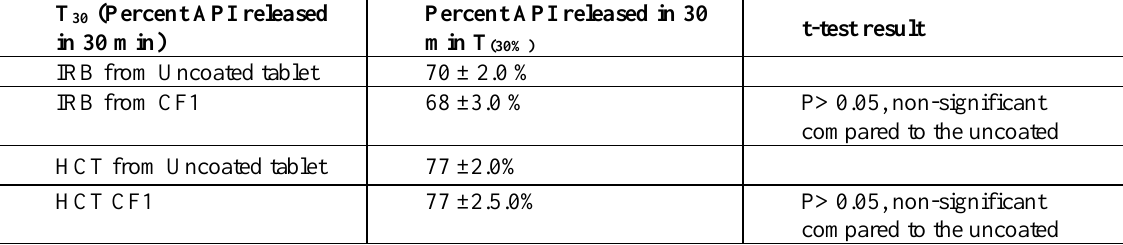
Figure 6.Dissolution profile of IRB and HCT of formula CF1 at 0.1 N HCl, 37 o C and 75 rpm showing T 30 .